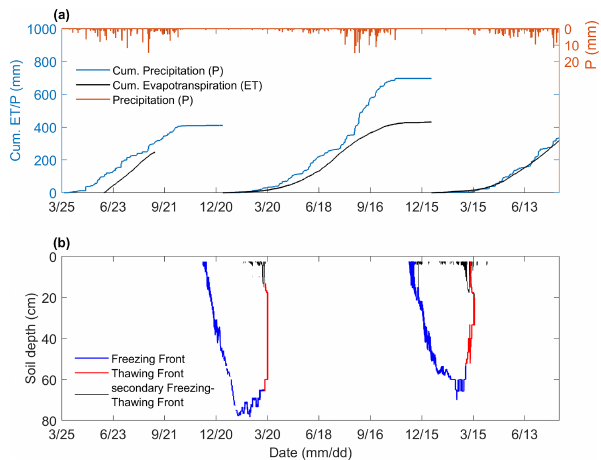
Figure 2. (a) Observed cumulative precipitation ( P ) and evapotran- spiration (ET) and (b) observed propagation of the freezing and thawing front, with blue, red, and black colors signifying the pri- mary propagation of freezing front and thawing front (FF and TF) and the secondary freezing and thawing front (sFTF) occurring at top soil layers, respectively, for the period 25 March 2016–12 Au- gust 2018 at the Maqu